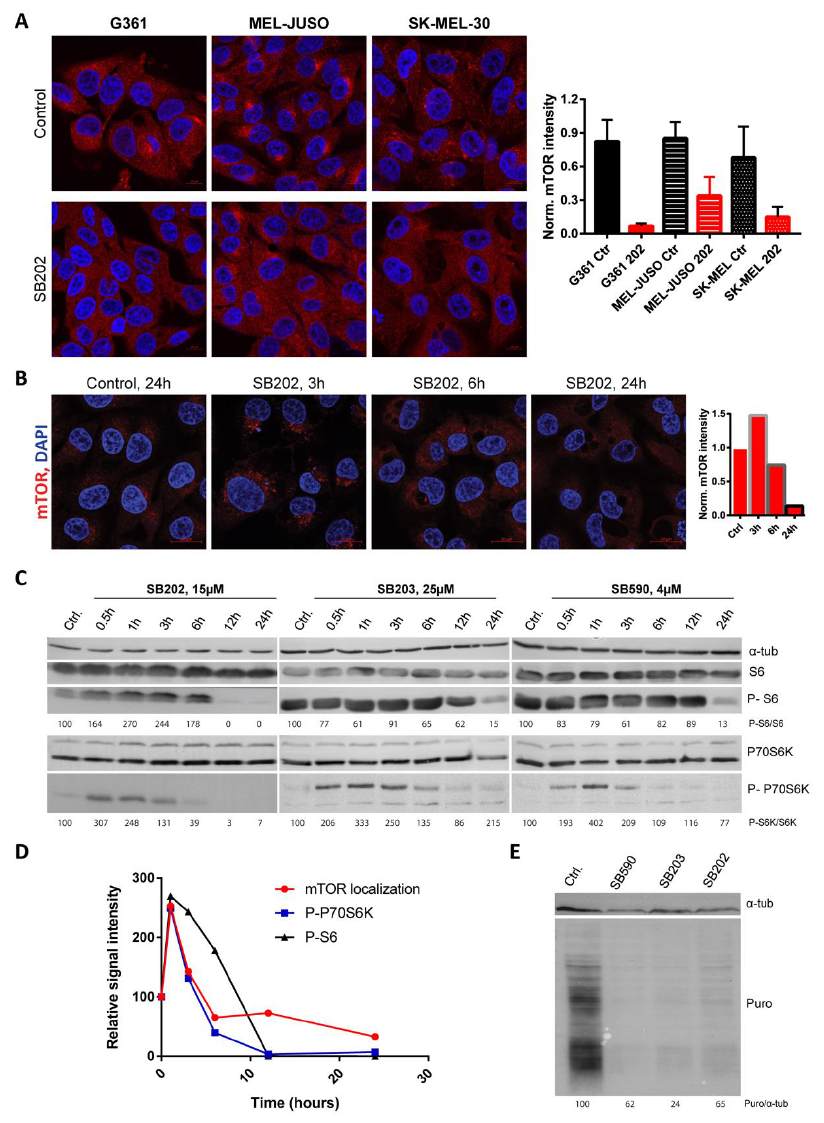
Figure 6. Pyridinyl imidazole compounds promote dynamic changes in mTOR activity in human melanoma cells. ( A ) BRAF-mutated G361 and NRAS-mutated MEL-JUSO and SK-MEL-30 human melanoma cells were stained for endogenous mTOR after 24 h treatment with SB202190 (SB202; 15 µM). Images were thresholded by a constant value of mTOR intensity, independently for each cell line, and mean mTOR intensity was quantified for three images per condition using ImageJ/Fiji. Scale bar: 10 µm. ( B ) Localization of endogenous mTOR in BRAF-mutated A375 melanoma cells treated for 0, 3, 12, and 24 h with SB202190 (SB202; 15 μM). Scale bar: 20 µm. The changes in mTOR signal intensity were quantified using ImageJ/Fiji and plotted in the graph as relative values. ( C ) Time-dependent changes in the activity of mTOR downstream target p70 S6K and phosphorylation of ribosomal S6 protein were analyzed by Western blotting. A375 cells were treated with pyridinyl imidazole compounds SB202190 (SB202), SB203580 (SB203), and SB590885 (SB590). ( D ) Graph illustrating changes in mTOR localization (Figure 6B) and activity (Figure 6C) at various time points upon SB202190 exposure. ( E ) Puromycylation assay in A375 cells treated with SB202190 (SB202), SB203580 (SB203), and SB590885 (SB590). Newly synthesized polypeptides were pulse-labeled with puromycin (Puro) and analyzed by Western blot. Tubulin alpha ( α -tub) served as a loading control. The ratio between puromycin and tubulin signal intensity was determined using ImageJ /